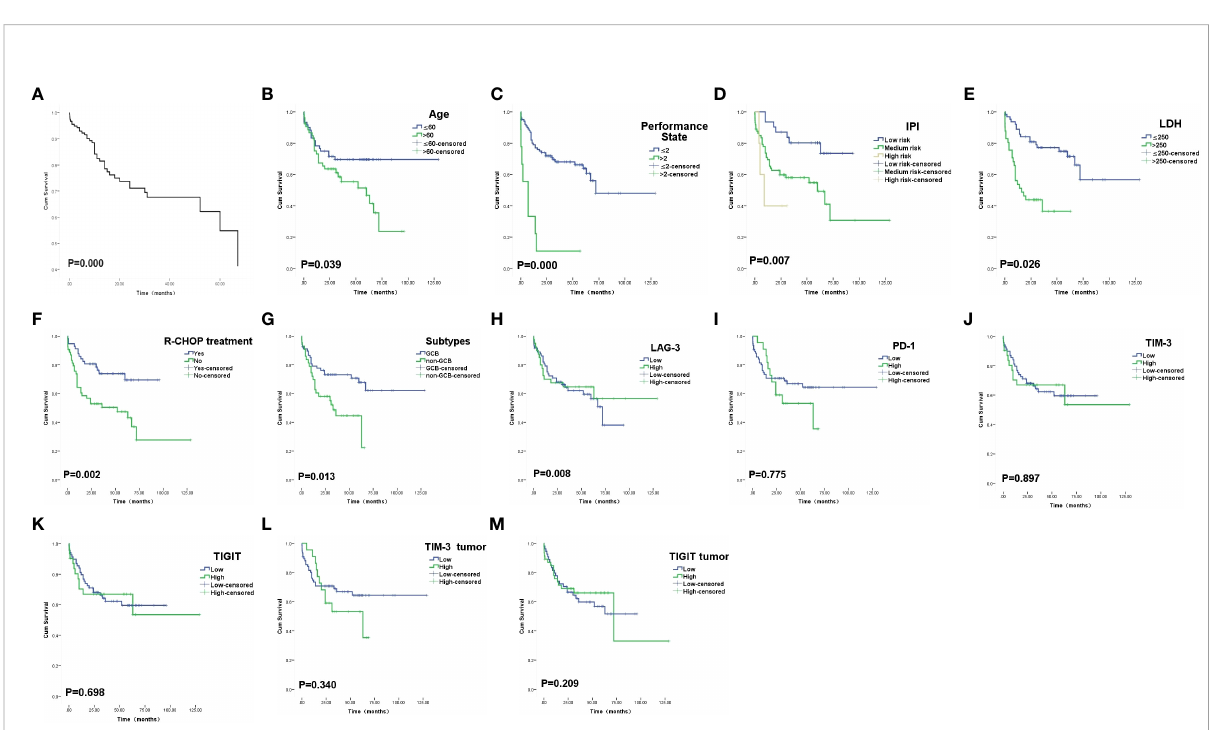
FIGURE 2 Overall survival curves. (A) The overall COX survival curves of these 174 patients with DLBCL. (B) Survival curves of patients according to Age. (C) Survival curves of patients according to PS score. (D) Survival curves of patients according to IPI index. (E) Survival curves of patients according to LDH. (F) Survival curves of patients according to R-CHOP treatment. (G) Survival curves of patients according to subtypes. (H) Survival curves of patients according to LAG-3 expression on TILs. (I) Survival curves of patients according to PD-1 expression on TILs. (J) Survival curves of patients according to TIM-3 expression onTILs. (K) Survival curves of patients according to TIGIT expression on TILs. (L) Survival curves of patients according to TIM-3 expression on tumor cells. (M) Survival curves of patients according to TIGIT expression on tumor cells.